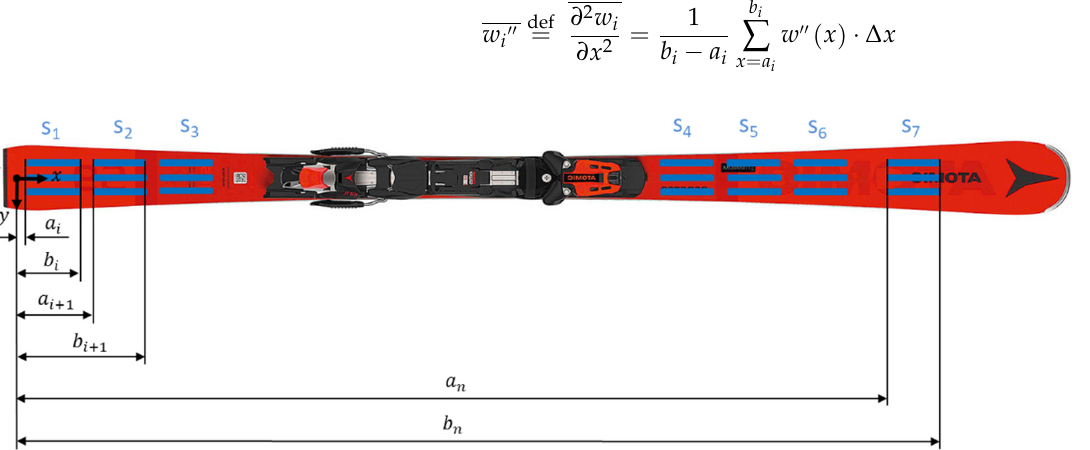
Figure 4. The ski instrumented with PyzoFlex ® technology-based sensors.